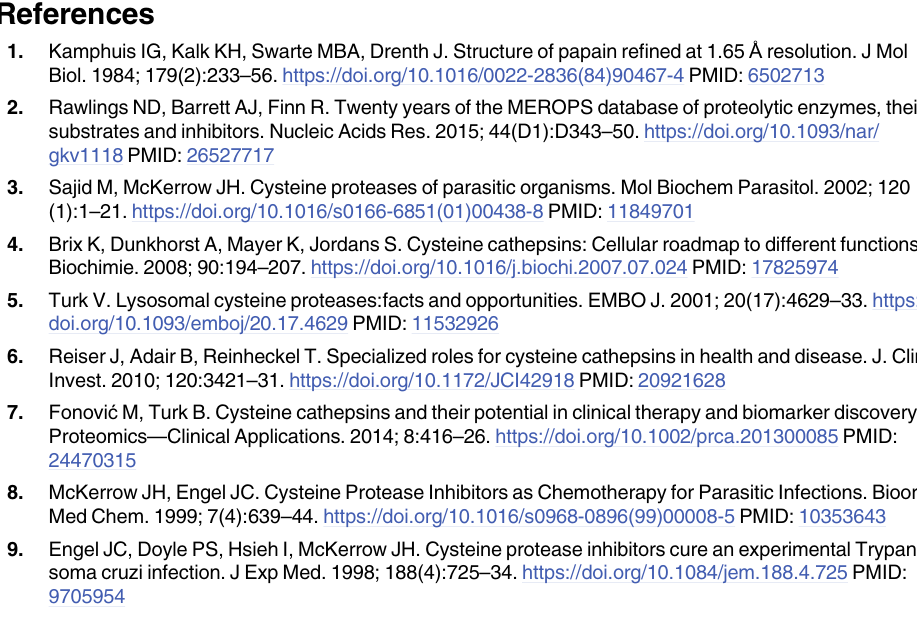
complexed with noncovalent and covalent forms of ligand ICL (black, red and green dots, respectively). S12 Fig. Projection over the first two principal components of cruzain (first row), cathep- sin K (second row) and cathepsin L (third row) simulation frames in it apo form and com- plexed with noncovalent and covalent forms of ligand IKR (black, red and green dots, respectively). S13 Fig. Projection over the first two principal components of cruzain simulation frames in it apo (black dots) form and complexed with noncovalent (red dots) and covalent forms (green dots) of ligands Neq0409 (first row), Neq0544 (second row), Neq0569 (third row) and Neq0568 (fourth